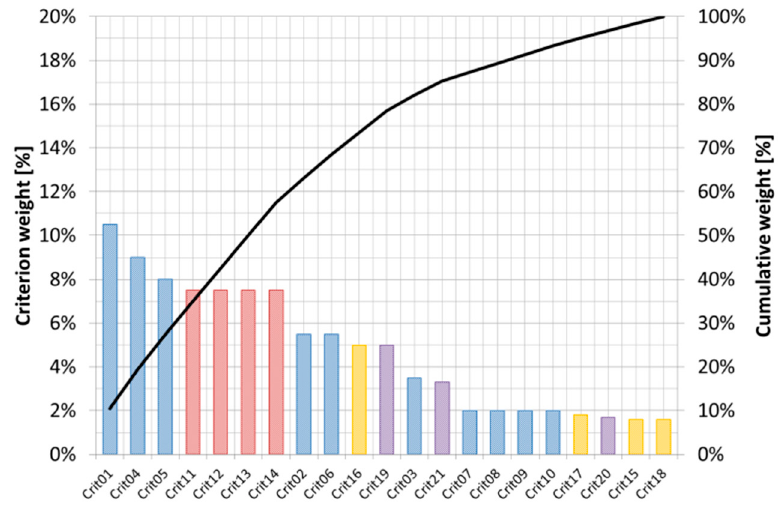
Figure 2. Ranking of compound weights for design criteria (Pareto chart). Criteria highlighted according to related functional requirement: F1 → blue, F2 → red, F3 → yellow, F4 → purple.